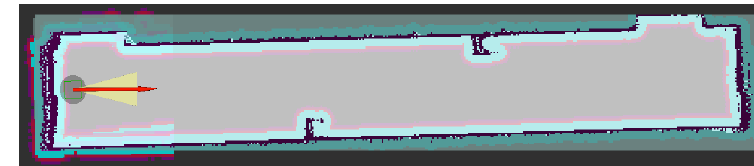
Figure 11. Cost map of simulated roadway based on the Karto algorithm.